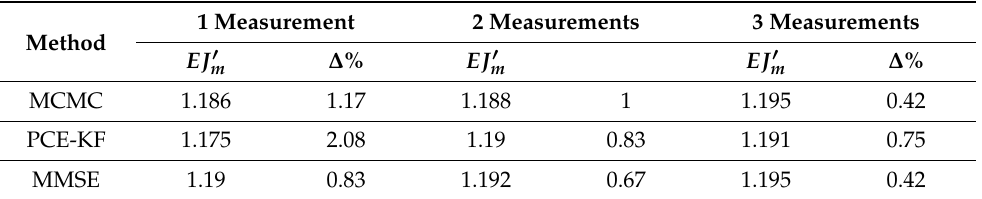
Table 6. Performance of the different updating procedures after mapping the response: comparison of posterior mode EJ (cid:48) m and EJ true = m + s = 1.2.